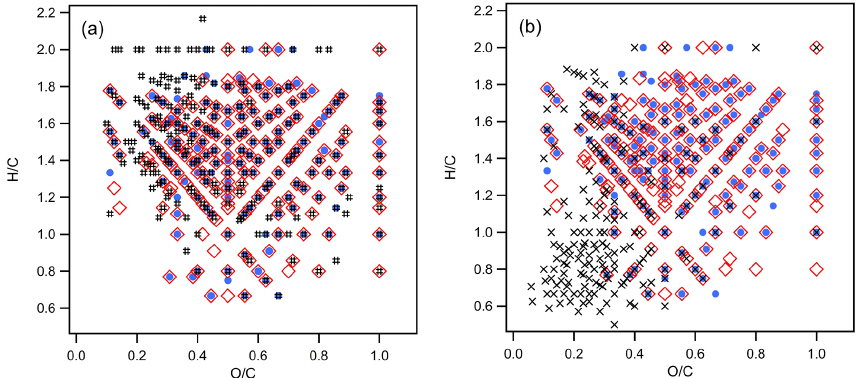
Fig. 3. Van Krevelen diagrams for compounds containing only carbon, hydrogen and oxygen in the samples from (a) α -pinene/O 3 , BVOC mixture/O 3 and the boreal forest, Hyytiälä, Finland; and (b) α -pinene/O 3 , BVOC mixture/O 3 and Tivoli Industrial Estate and Docks, Cork, Ireland. Filled blue circles correspond to species from α -pinene/O 3 experiment, red diamonds to BVOC mixture/O 3 experiments, black hashes to the Hyytiälä samples and black crosses to the Tivoli Industrial Estate and Docks, Cork samples.